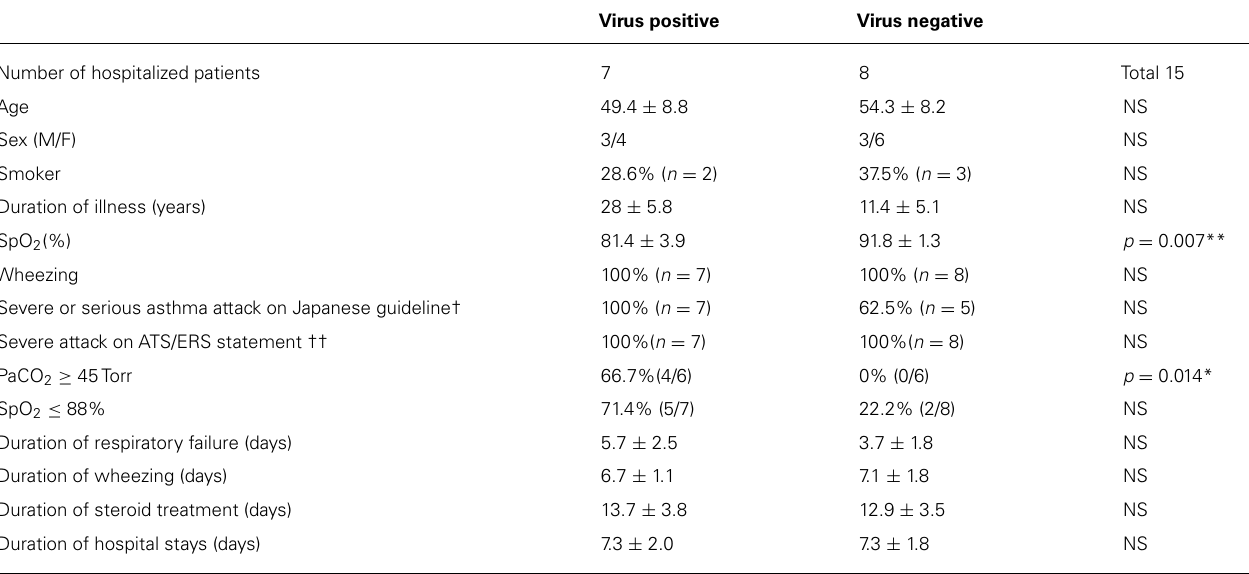
Table 4 | Clinical characterization of hospitalized patients with asthma attack based on the presence of virus